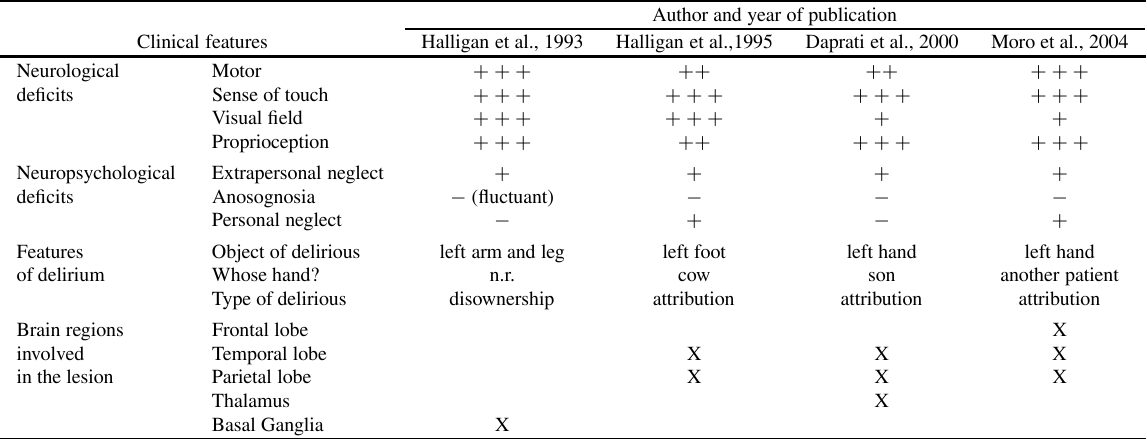
Table 1 Cases of dissociation between SP and AHP reported in the recent literature. Neurological, neuropsychological and anatomical characteristics of non-anosognosic patients with somatoparaphrenic delusions reported in the literature quoted in the Pub Med database [see also 2]. – No de fi cit; + mild de fi cit; +++ severe de fi cit. n.r. Not reported in the original paper. “Disownership”: simple feeling of non-belonging in which, contrary to “attribution”, the patient does not recognize a limb as his/her own one, but does not explicitly identify the believed owner of the deluded body